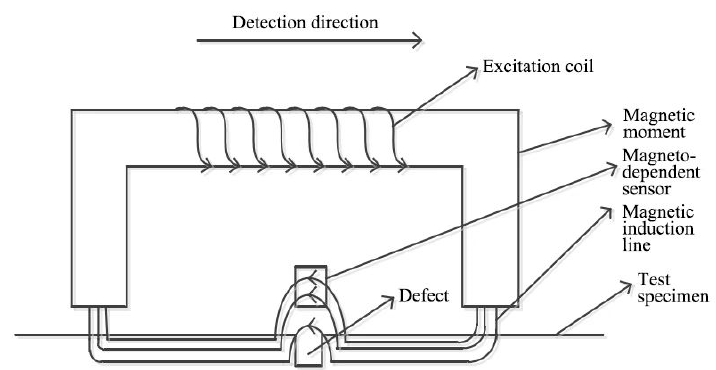
Figure 2. Magnetic flux leakage technique.